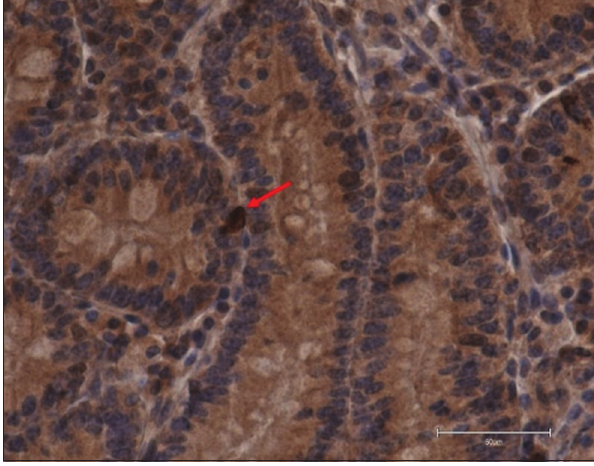
Figure-4: Ghrelin immunoreactive+cell (arrow) in a 13-week-old calf from the middle of the duodenum of a control group (400×, DAB + hematoxylin, scale bar 50 µ m).